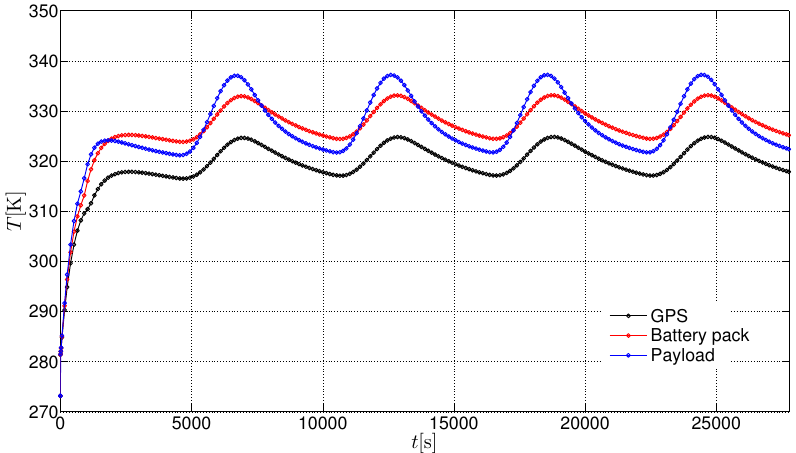
Figure 12. Average temperature in the electronic boards as function of time ( β = 90 ◦ ).